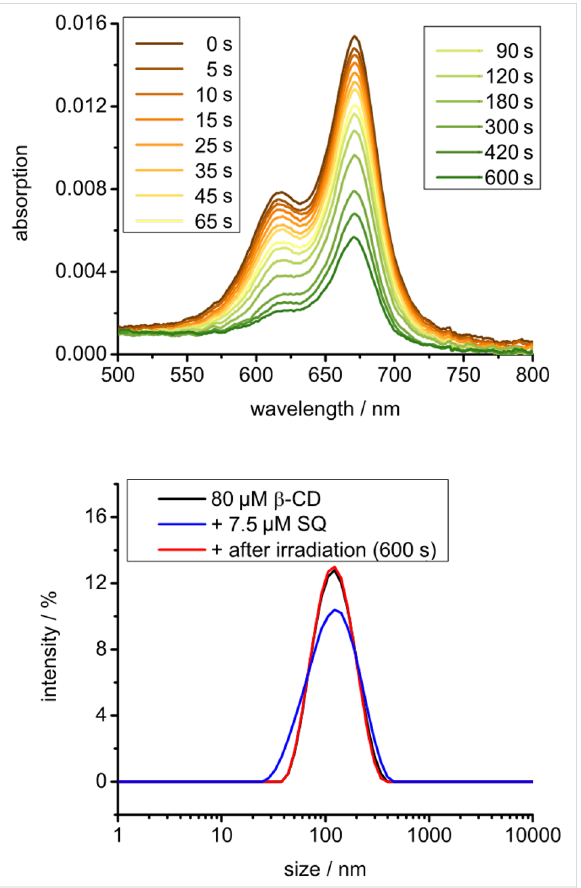
Figure 5: Top: Absorption spectra at different time points during irradi- ation of a CDV solution with AdSq immobilised on the vesicle surface. Bottom: DLS spectra before and after irradiation. [AdSq] = 7.5 µM, [CDV] = 80